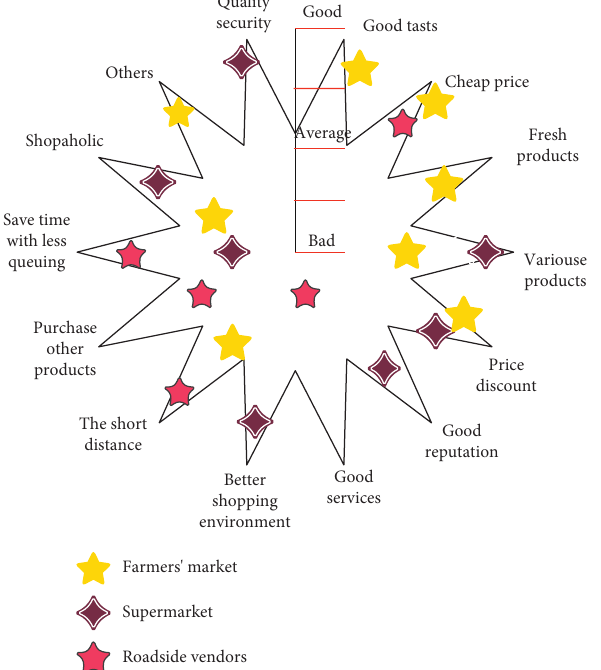
Figure 11: Radar distribution map of the influence intensity of various factors in different sales